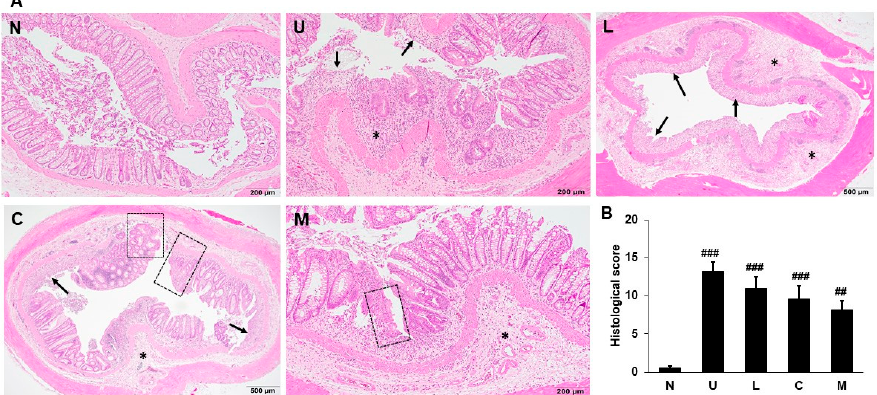
Figure 3. Effects of Lycium barbarum polysaccharides (LBP) and capsaicin (CAP) on histological changes. ( A ) Representative distal colons stained by hematoxylin and eosin; ( B ) Histological scores. N: control group, U: ulcerative colitis induced group, L: LBP treated group, C: CAP treated group, M: mixed LBP and CAP treated group. Data are presented as mean ± SEM ( n = 5). The arrow indicates erosion or ulceration of the epithelial layer. The * symbol indicates extent of inflammation. The dotted-line square indicates regeneration of the epithelial layer. ## p < 0.01 compared to the N group. ### p < 0.001 compared to the N group.